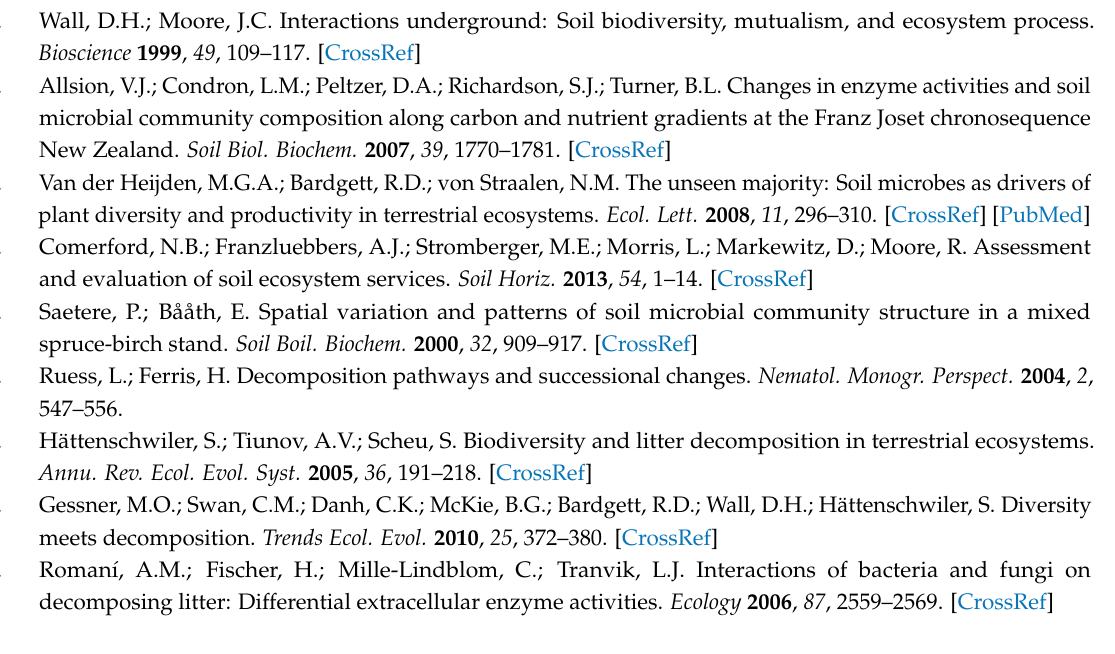
Figure S1: Core microbial community composition of bacterial ( a ) and fungal ( b ) in four treatments, Table S1: Differences among the three forest management methods, Table S2: Composition of bacterial community at the phylum level, Table S3: Composition of fungi community at the phylum level, Table S4: Correlation between soil nutrients and relative abundance of the dominant phyla in the bacterial community, Table S5: Correlation between soil nutrients and relative abundance of the dominant order in the bacterial community, Table S6: Correlation between soil nutrients and relative abundance of the dominant phyla in the fungal community, Table S7: Correlation between soil nutrients and relative abundance of the dominant order in the fungal